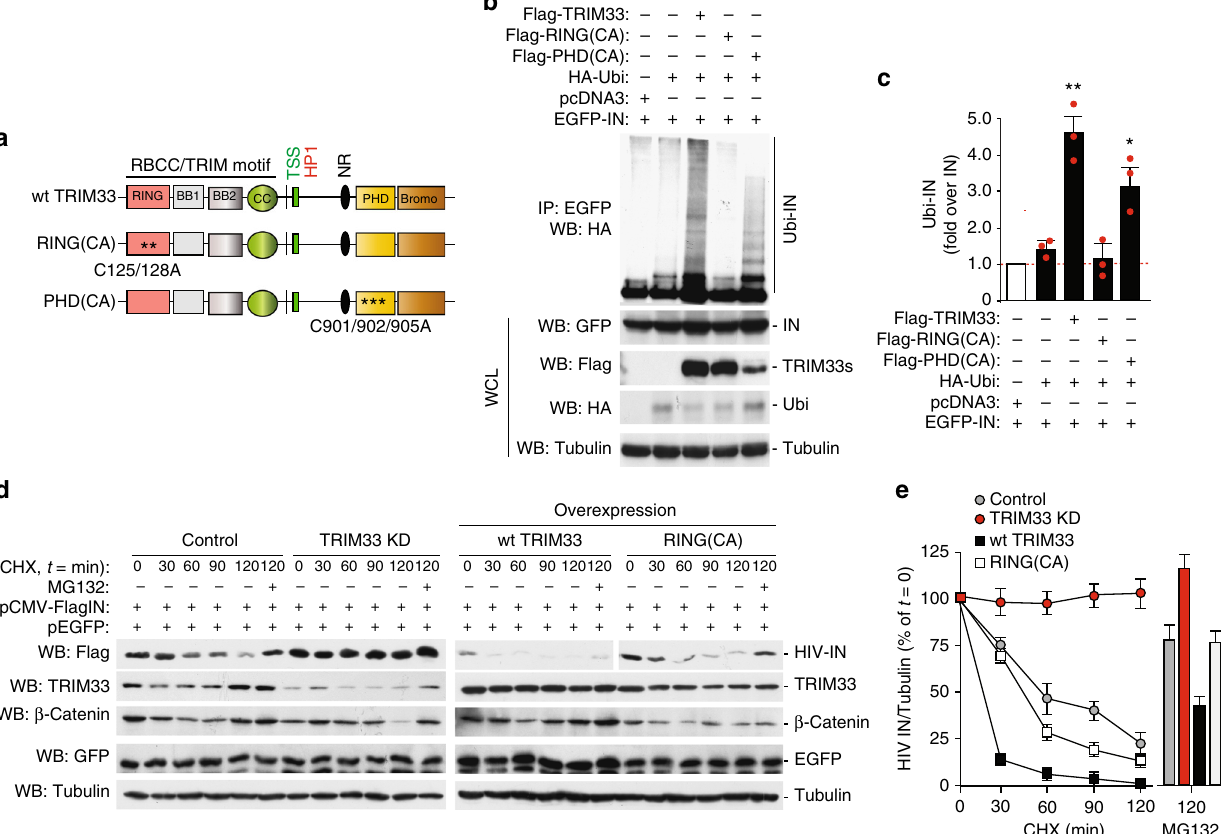
Fig. 5 Mapping the TRIM determinants determining integrase stability. a Schematic representation of the TRIM33 protein and its catalytically inactive mutants in the RING and PHD domains [RING(CA) and PHD(CA) respectively]. b Integrity of the TRIM33 RING motif is essential for HIV-1 IN ubiquitination. HEK293T cells were transfected with combinations of plasmids expressing HA-ubiquitin, EGFP-IN, Flag-TRIM33 and its catalytically inactive mutants (RING and PHD), and pcDNA3 as an empty vector. Cells were harvested after 5 h treatment with proteasome inhibitor and cell lysates were immunoprecipitated with anti-GFP antibody. Ubiquitin-conjugated IN (Ubi-IN) was detected by immunoblotting with anti-HA antibody (upper picture). The lower pictures show the levels of expression of the transfected plasmids in whole cell lysates control expression of transfected proteins after immunoblotting with the respective antibodies. c Quanti fi cations of the amount of ubiquitinated IN protein (Ubi-IN) in whole cell extracts, normalized over total IN. Experiments were performed as in panel b . Data are mean ± SEM; n = 3 independent experiments; * P < 0.05; ** P < 0.01; one-way ANOVA. d Representative immunoblot showing the stability of HIV-IN in HeLa cells stably expressing an shRNA against TRIM33 (TRIM33 KD) and transfected to overexpress wild-type TRIM33 or the C125A/C128A catalytically inactive (RING(CA). Cells were co-transfected with Flag-IN and EGFP, as transfection and speci fi city control; 48 h later, the levels of IN were assessed by anti-Flag immunoblotting. Tubulin served as a loading control; β -catenin was used to con fi rm effect of MG132 treatment; knock-down and overexpression of TRIM33 variants were veri fi ed by anti-TRIM33 immunoblotting. e Quanti fi cation of the effects of TRIM33 knock down and overexpression on the levels of HIV-1 IN. Results of three independent experiments (mean ± SEM) performed as in panel d are expressed, after normalization for Tubulin, as a percentage of time = 0 for each